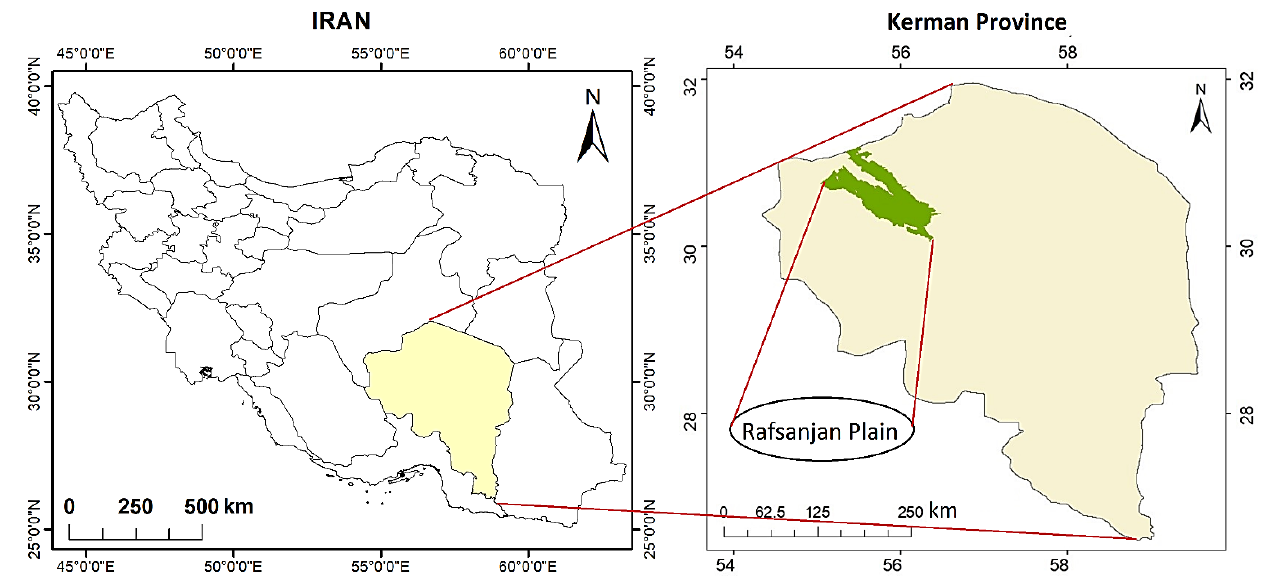
Figure 1. Geographical location of Rafsanjan Plain within Iran and Kerman Province.